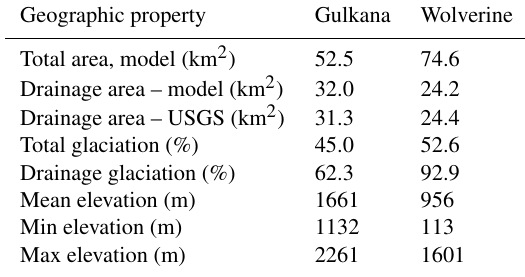
Table 1. Select geographic properties of Gulkana and Wolverine study domains and watersheds (Fig. 1). “Total” refers to properties aggregated over the study domain, “drainage” refers to properties aggregated over the area contributing to the USGS stream gage, and all elevations are with respect to the study domain.